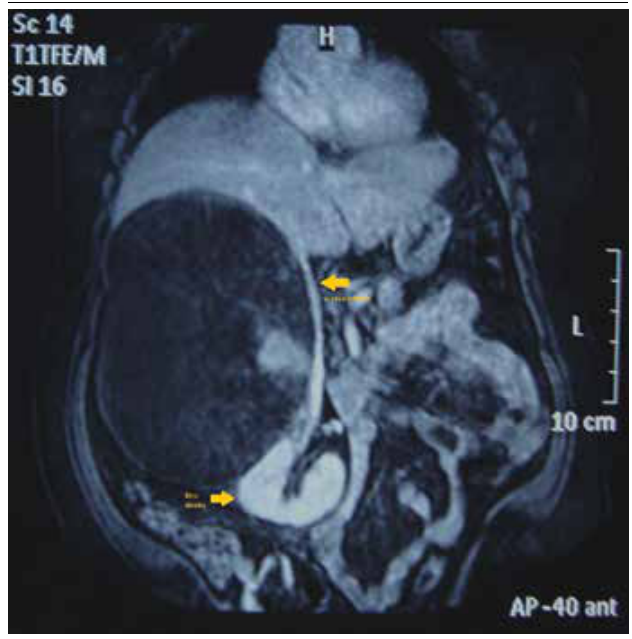
figuRE 2 − Coronal contrast-enhanced T1-weighted abdominal MRI slice showing that the lesion occupies the adrenal area and exerts significant mass effect on the right hepatic lobe and the homolateral kidney (lower arrow), revealing hyper-intense signal in this phase. One may also notice the inferior vena cava partially compressed by the lesion (upper arrow) MRI: magnetic resonance imaging; T1: spin-lattice relaxation